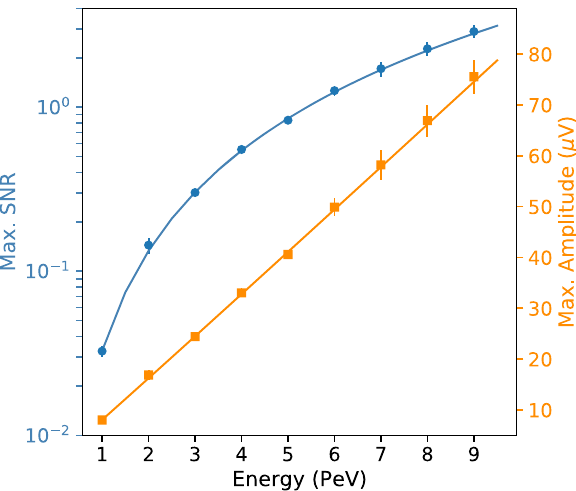
Fig. 2 The SNR for an antenna on the Cherenkov ring at various fre- quency bands, for a 10 PeV gamma-ray shower with θ = 61 ◦ and α = 79 ◦ . This is an updated version of Figure 4(b) in [1]